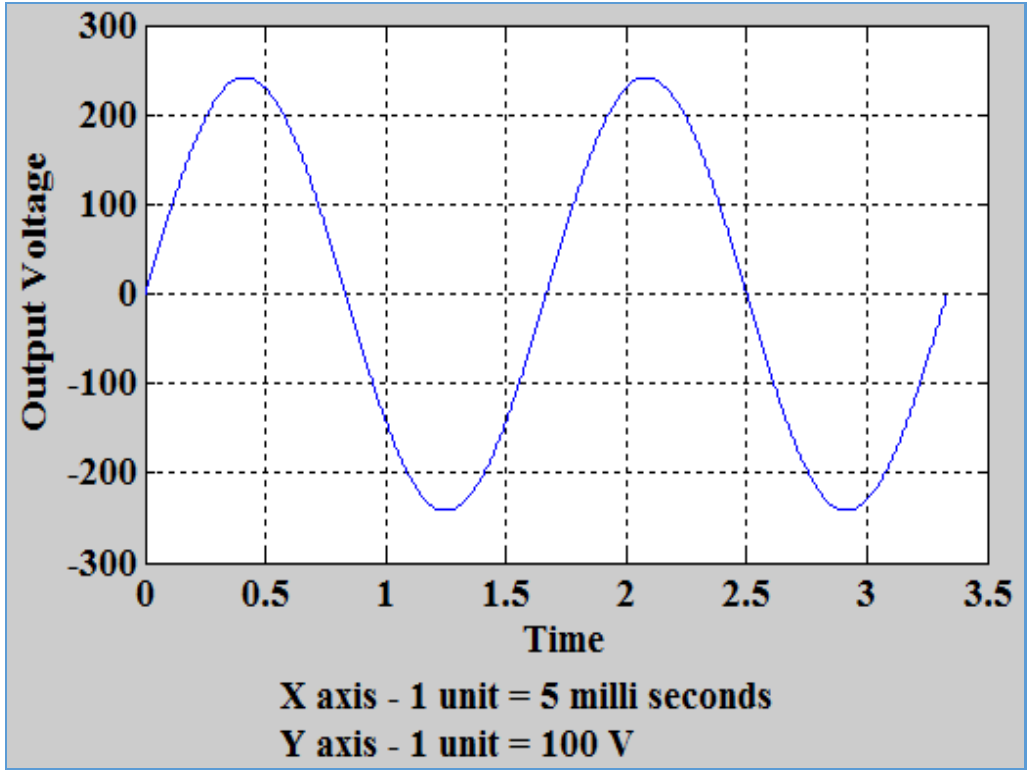
Figure 25. Output voltage vs. Time for R load—400 ohm—Simulation for 60 Hz frequency.